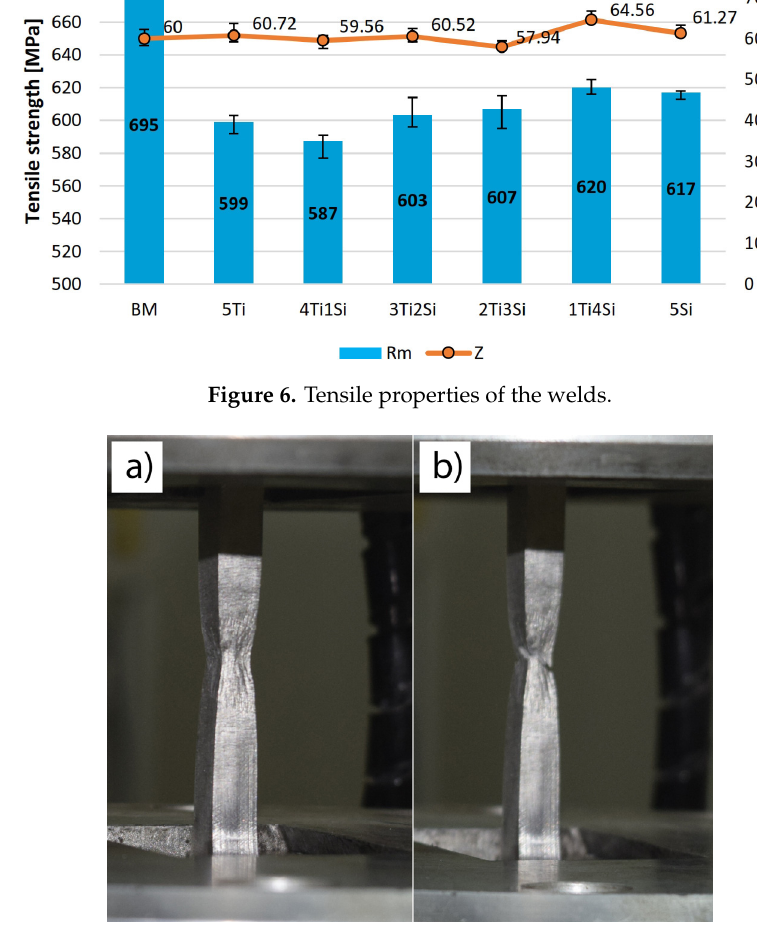
Figure 7. Necking in two tensile 1Ti4Si specimens: closer to the weld beginning ( a ); closer to the weld end ( b ) .